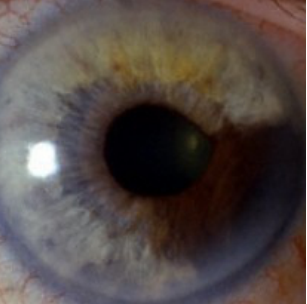
Figure 5. Image with an abnormality in the bottom right part of the iris (image used for